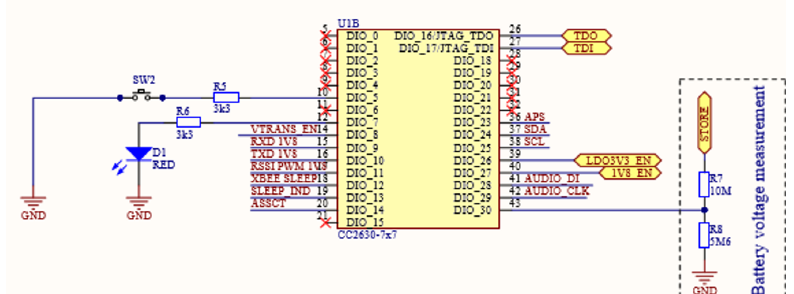
Figure 8. GPIOs and battery voltage monitoring